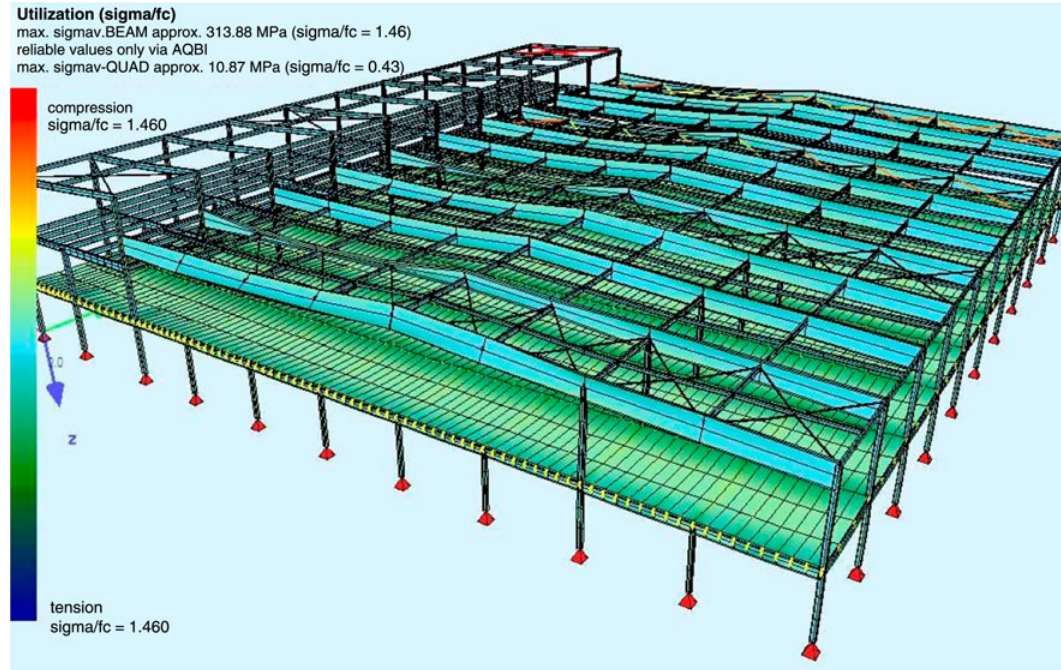
Fig. 18. Example of the stress results for structural analysis